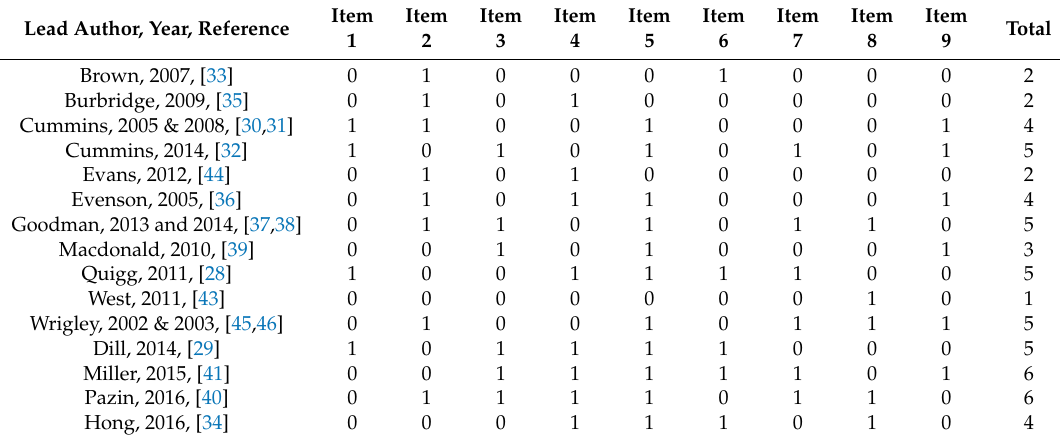
Table 3. Risk of bias ratings for included